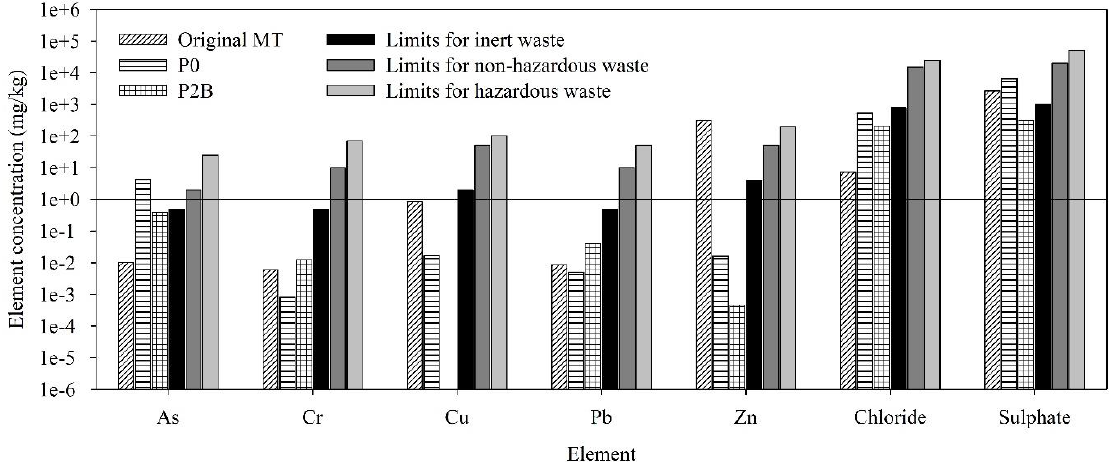
Figure 12. Element concentrations in the leaching solution (test LTT1 ) obtained from paste P2B and in comparison with the acceptance limits defined in 2003/33/EC.